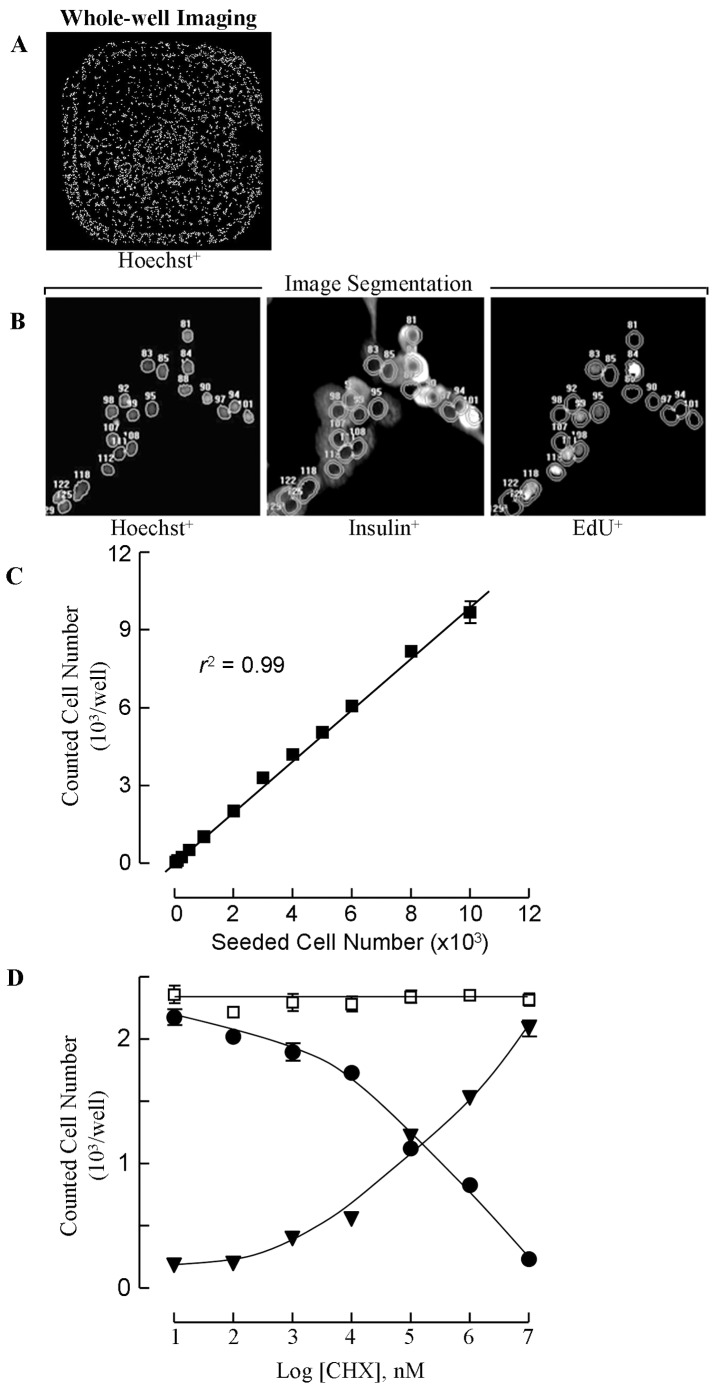
Image analysis for counting the number of living and dead beta cells per well and determining the percentages of EdU-positive cells.Purified rat beta cells were seeded in 96- or 384-well plates and stained by Hoechst 33342 (Ho) and propidium iodide. Whole-well images were taken at a resolution that allows identification and counting of all cells distinguishing PI-positive and PI-negative cells (A,C,D). IPLab and AttoVision software packages were used for image processing and quantification. Following image segmentation, every cell is numbered and the number of living (Ho-pos, PI-neg) and dead cells (Ho-pos-PI-pos) are determined. Induction of apoptosis by cycloheximide-CHX (8) causes within 48 h a dose-dependent increase in the number of dead cells (black triangles) and decrease in the number of living cells (black circles) without change in the total numbers (while squares) that are counted (D) (means ±SEM of three independent experiments). Image segmentation delineates nuclear and cytoplasmic boundaries of every cell through dynamic thresholding that detects changes in Hoechst fluorescence above background; the cytoplasm was designated by the area between the nuclear boundary and a three pixel-wide annular ring drawn around it (B). Following staining for insulin and EdU, the nuclear image is superimposed on the EdU and insulin immunofluorescence images and fluorescence intensity is averaged for pixels within the nuclear or cytoplasmic area so that the percentages of single or double-positive cells can be determined.